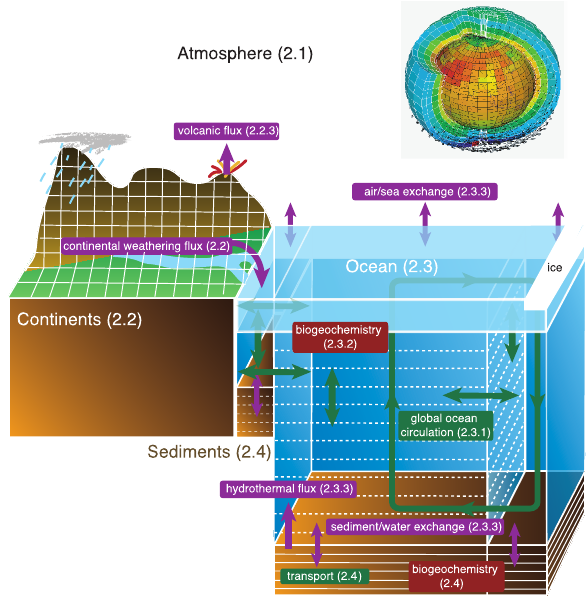
Fig. 1. General structure of GEOCLIM reloaded. A detailed description of transport (green) and transformation (red) processes within each compartment, as well as of the exchange fluxes through their interfaces (purple) is given in the sections indicated in brackets.